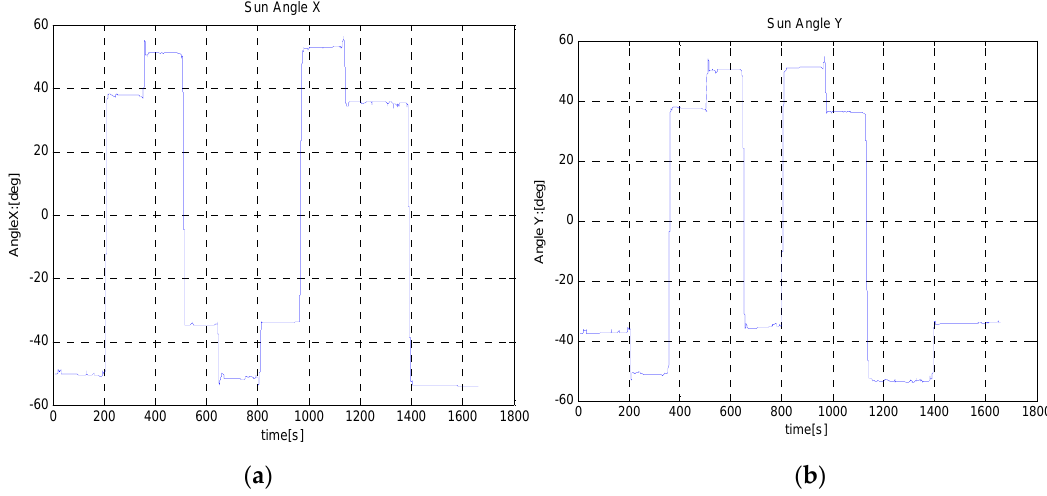
Figure 12. Sun sensor output during Test (B ‐ i) with 90° rotation steps in the CW and CCW directions. ( a ) Angle ‐ x is the angle between z ‐ axis and projection of Sun ray on x ‐ z plan; ( b ) Angle ‐ y is the angle between z ‐ axis and projection of Sun ray on y ‐ z plan.